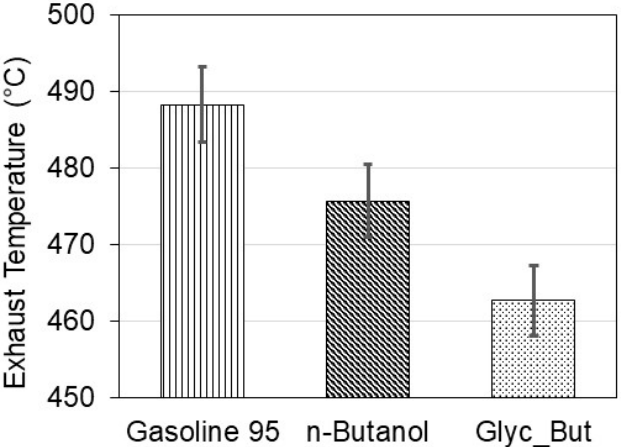
Figure 8. Exhaust gas temperature for the tested fuels at optimal spark timings.